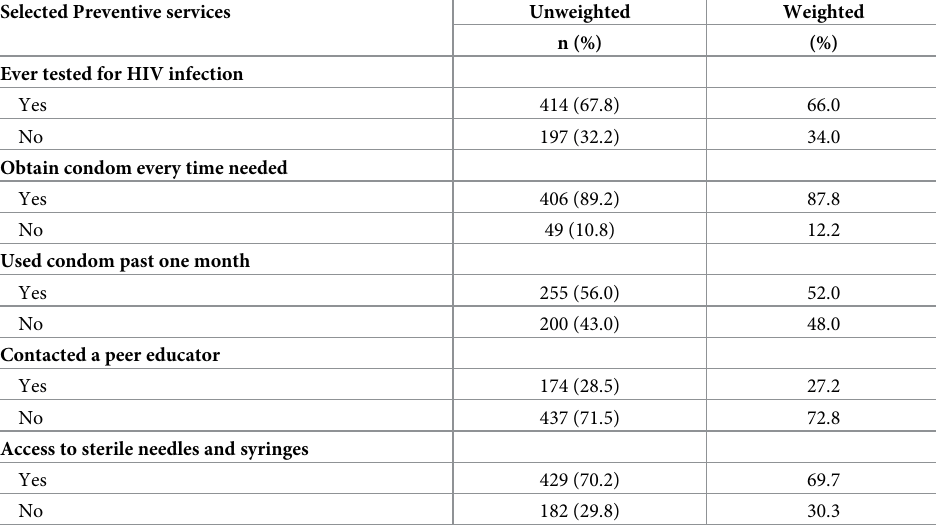
Table 2. Access to HIV prevention services among people who inject drugs in Dar es Salaam, Tanzania (n = 611). Selected Preventive